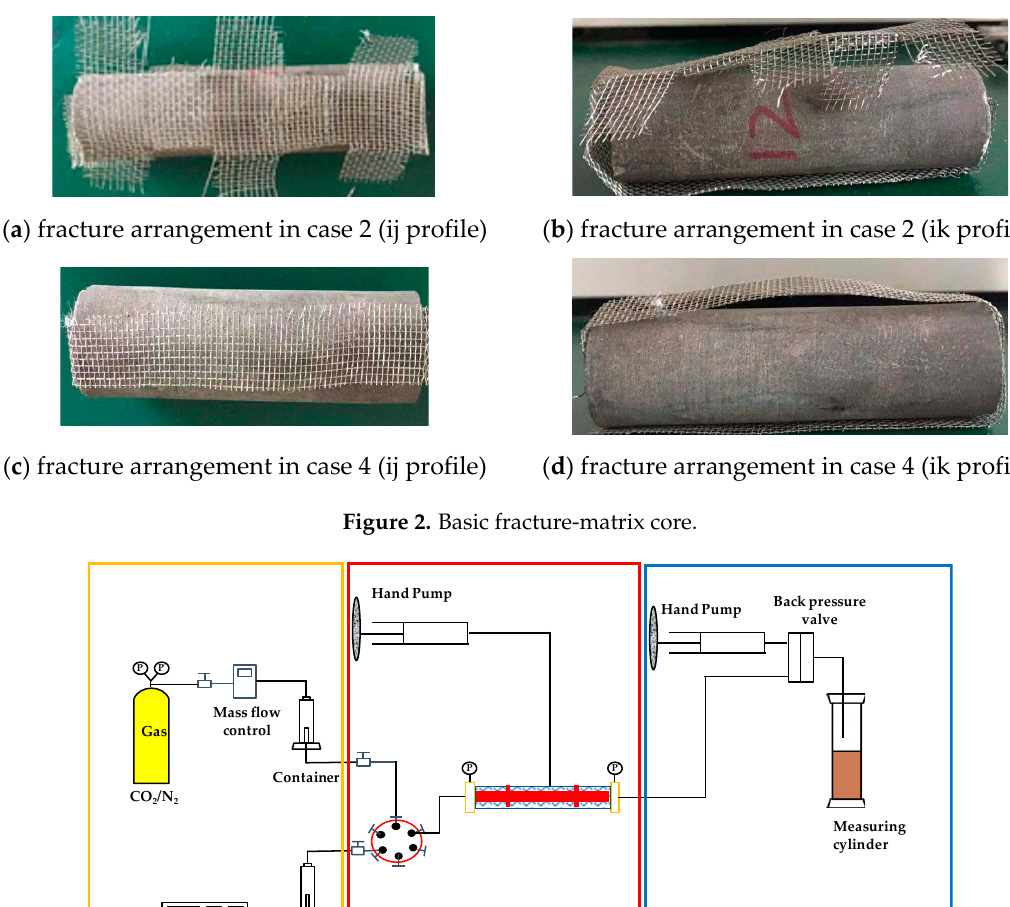
Figure 3. Flowchart of the huff-‘n-puff experiments.